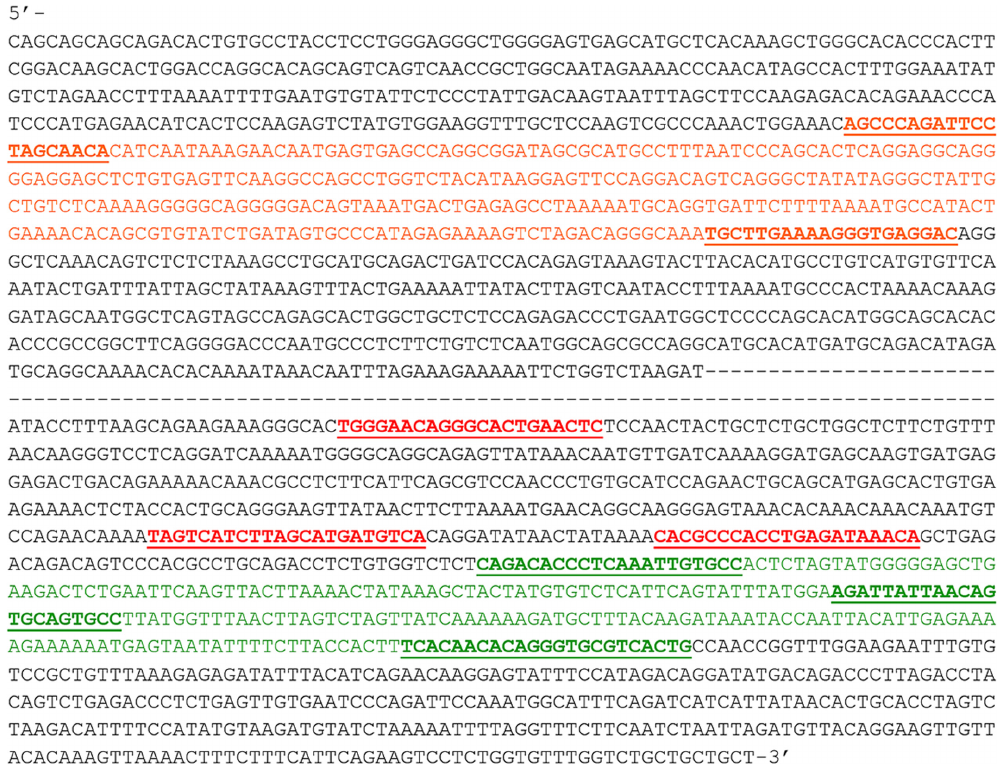
Fig 1. Sequence of the B-specific 2200 bp ISSR Amplicon Obtained from gDNA of a Random Animal with 1B Karyotype. Both, 991 nt at the 5 ’ -end and 995 nt at the 3 ’ -end listed here were completely identical among all ten clones. Approximately 200 intermediate bases without readable sequence results were omitted from the shown sequence. Sequences of eight designed specific primers are underlined: DD5F , DD5R , SR1F , SR1R , SR2R , LD1F , LD1R , and LD2R . Sequences of two fragments amplified by qPCR are colored in orange at 5 ’ end (321 bp) and green at 3 ’ end (251